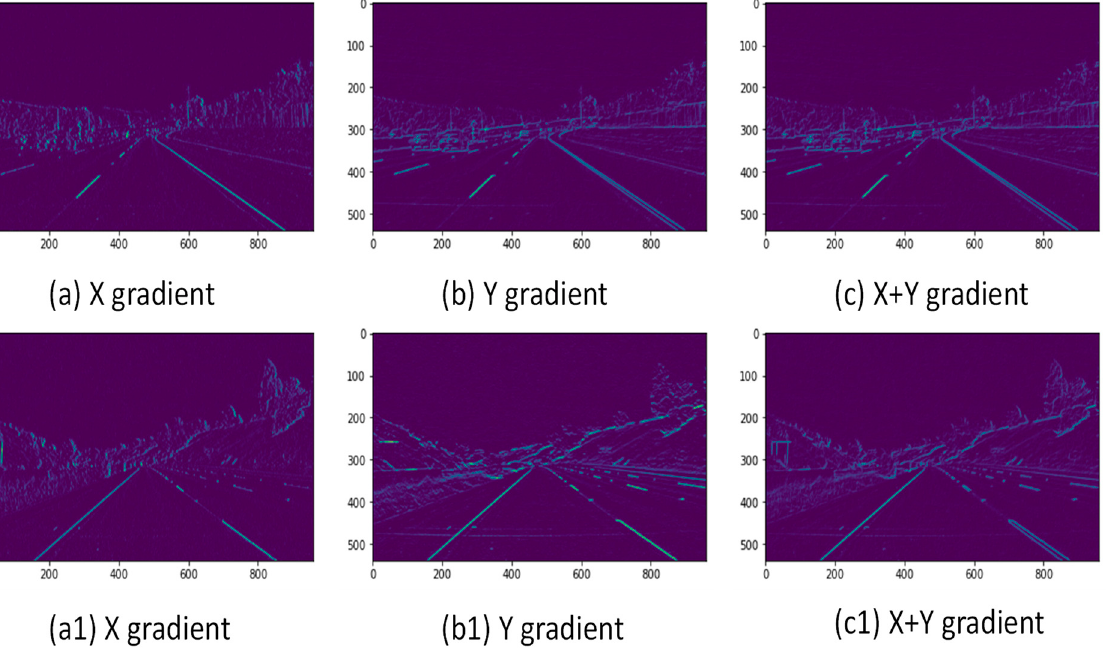
Figure 4. Using an X gradient, Y gradient, and an X + Y gradient with the Sobel edge detection operator.